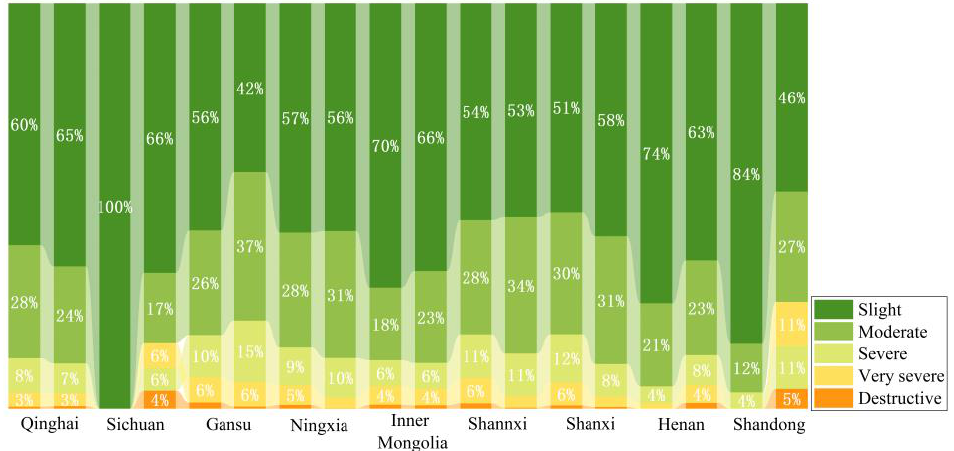
Figure 7. The area ratio of erosion intensity in nine provinces in the YRB in 2020 (the results in the bulletin on the left, the simulation results on the right).